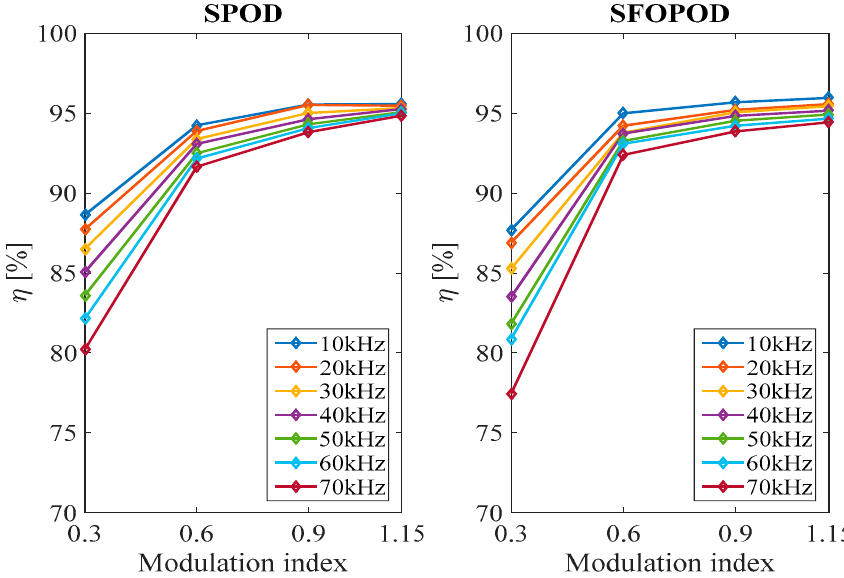
Figure 21. Experimental conversion efficiency trends of SPOD and SFOPOD schemes.